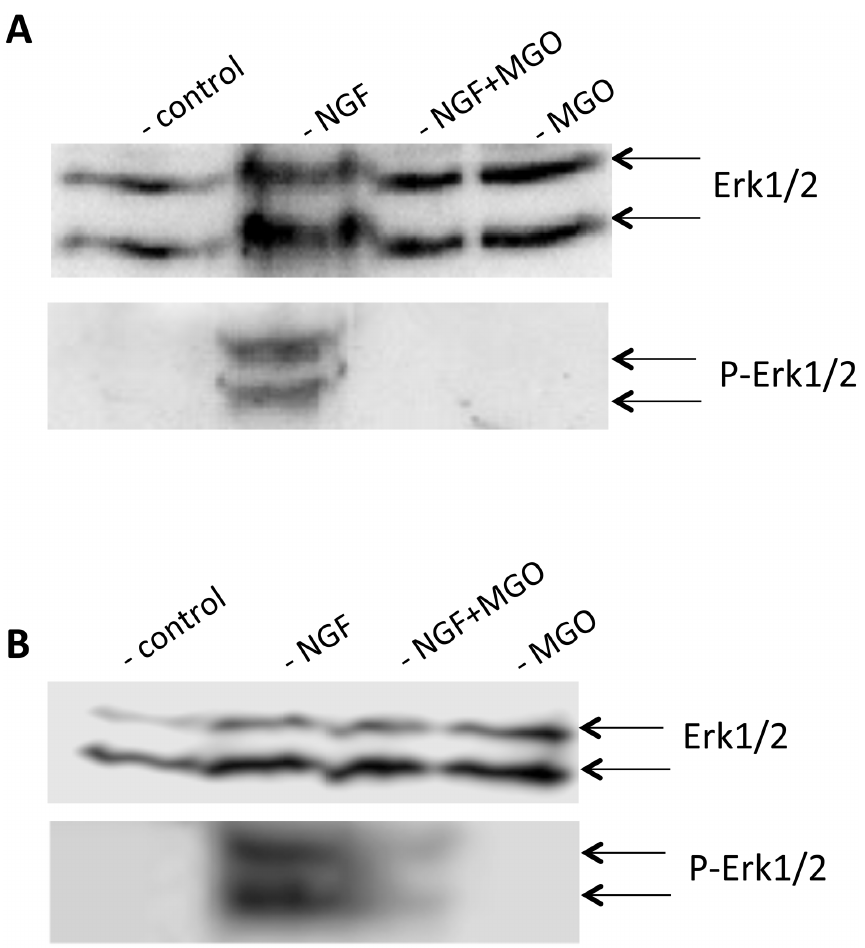
Figure 8. ERK1/2 activation of AGE-modified PC12 cells. PC12 cells were incubated with PBS or 1 mM MGO for 4 hours and stimulated with 100 ng/ml NGF. A. Cells were harvested, washed, and solubilized. Solubilizates were centrifuged and subjected to SDS-gel electrophoresis. Proteins were blotted and detected using monoclonal ERK1/2 antibody for equal loading and monoclonal phospho ERK1/2 antibody for the detection of ERK activation. B. After MGO-treatment, cells were cultured for further 72 hours, harvested, washed, and solubilized. Solubilizates were centrifuged and subjected to SDS-gel electrophoresis. Proteins were blotted and detected using monoclonal ERK1/2 antibody for equal loading and monoclonal phospho-ERK1/2 antibody for the detection of ERK